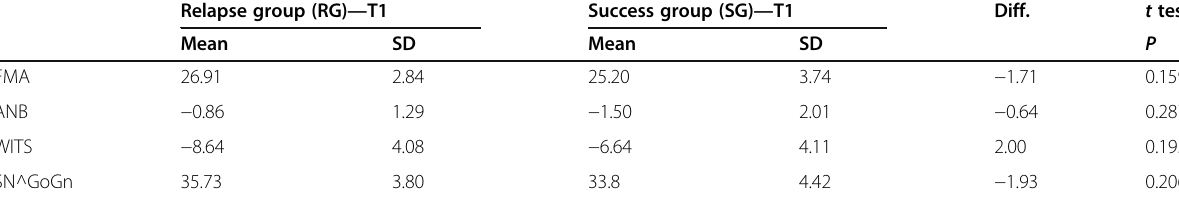
Table 3 Statistical comparisons between groups at T0: cephalometric analysis Relapse group (RG) — T1